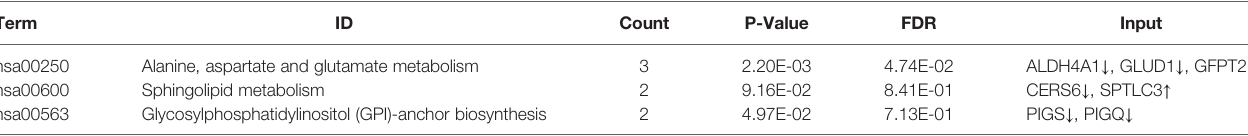
TABLE 6 | KEGG enrichment pathway of